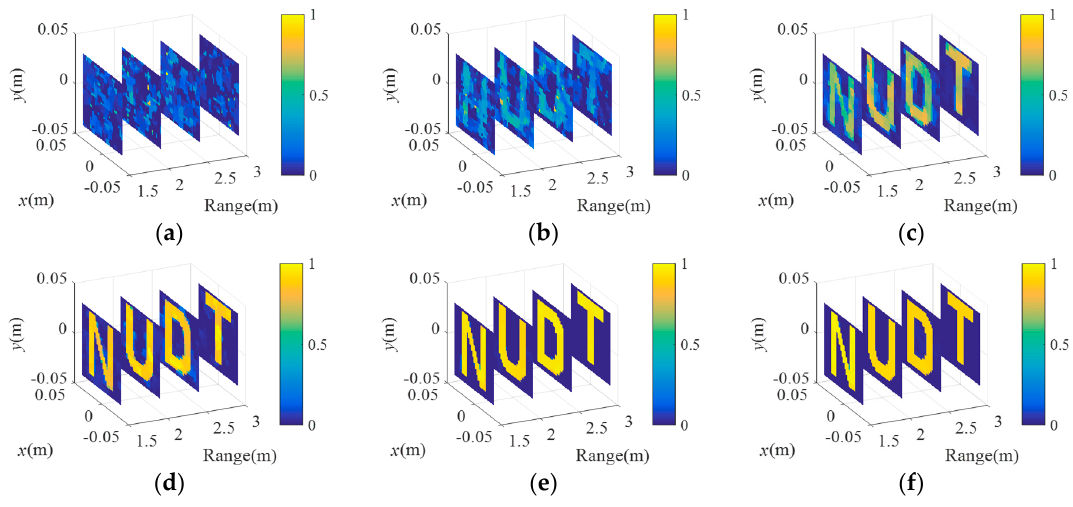
Figure 8. Comparison of imaging results for C-TCAI and GM-TCAI for extended targets at various SNRs. ( a – c ) Imaging results for C-TCAI at − 25 dB, − 15 dB, and − 5 dB; ( d – f ) imaging results for GM-TCAI at − 25 dB, − 15 dB, and − 5 dB.